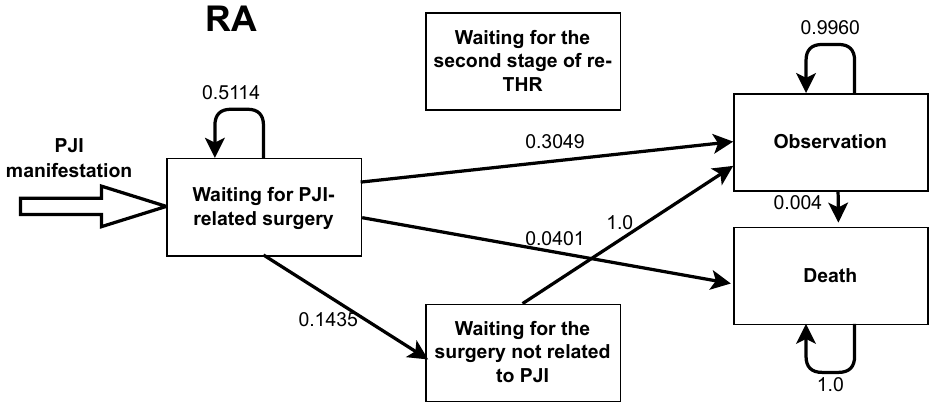
Figure A3. Markov model transition probabilities for resection